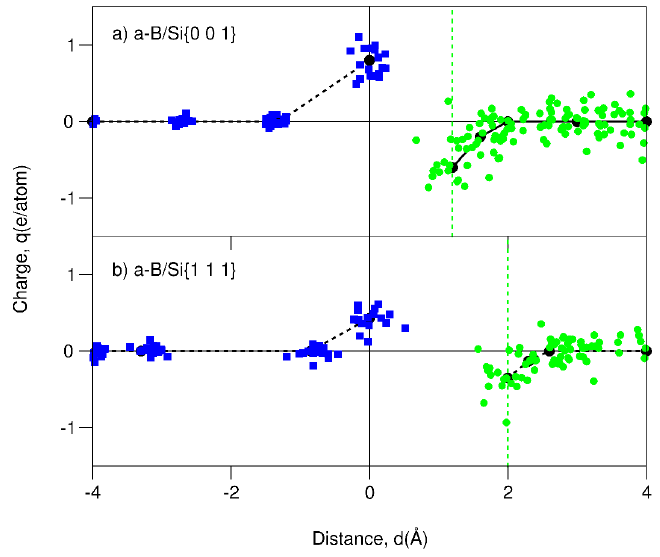
Figure 10. Charges at the a-B/c-Si interfaces. The blue squares represent charges at the Si sites and green spheres represent charges at the B sites. The solid black lines indicate the peak of the outmost Si, while the dotted green lines represent the first peak of B